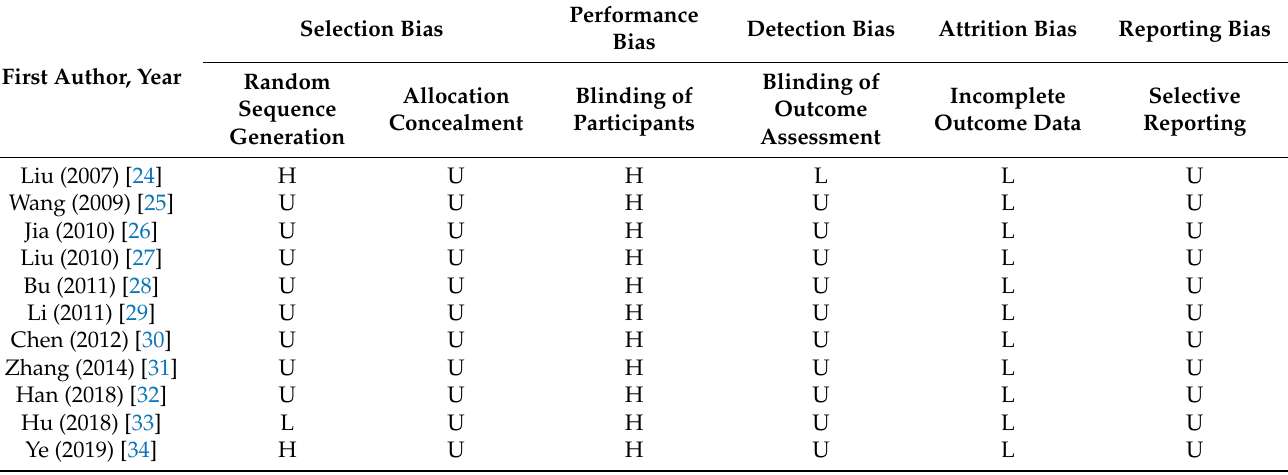
Table 4. Risk of bias assessment.